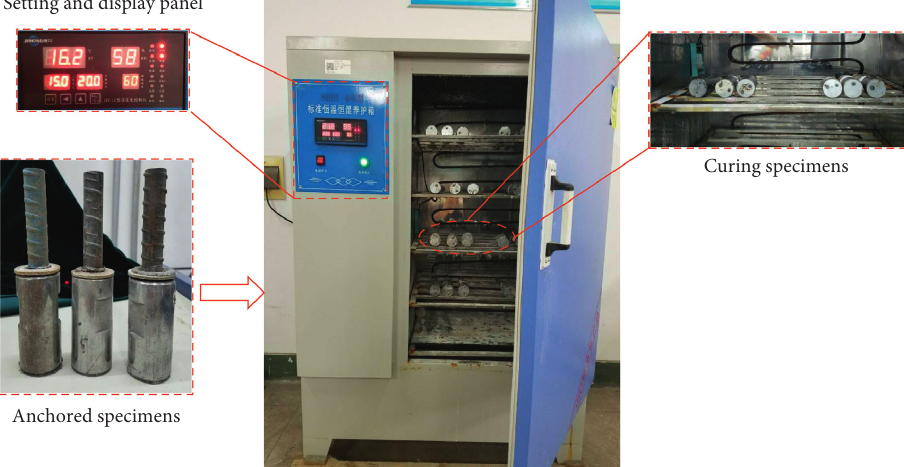
Figure 14: Photographs of equipment used for curing the anchorage specimens, showing details of the setting and display panel (upper left), anchored specimens (lower left), and curing specimens (upper right).